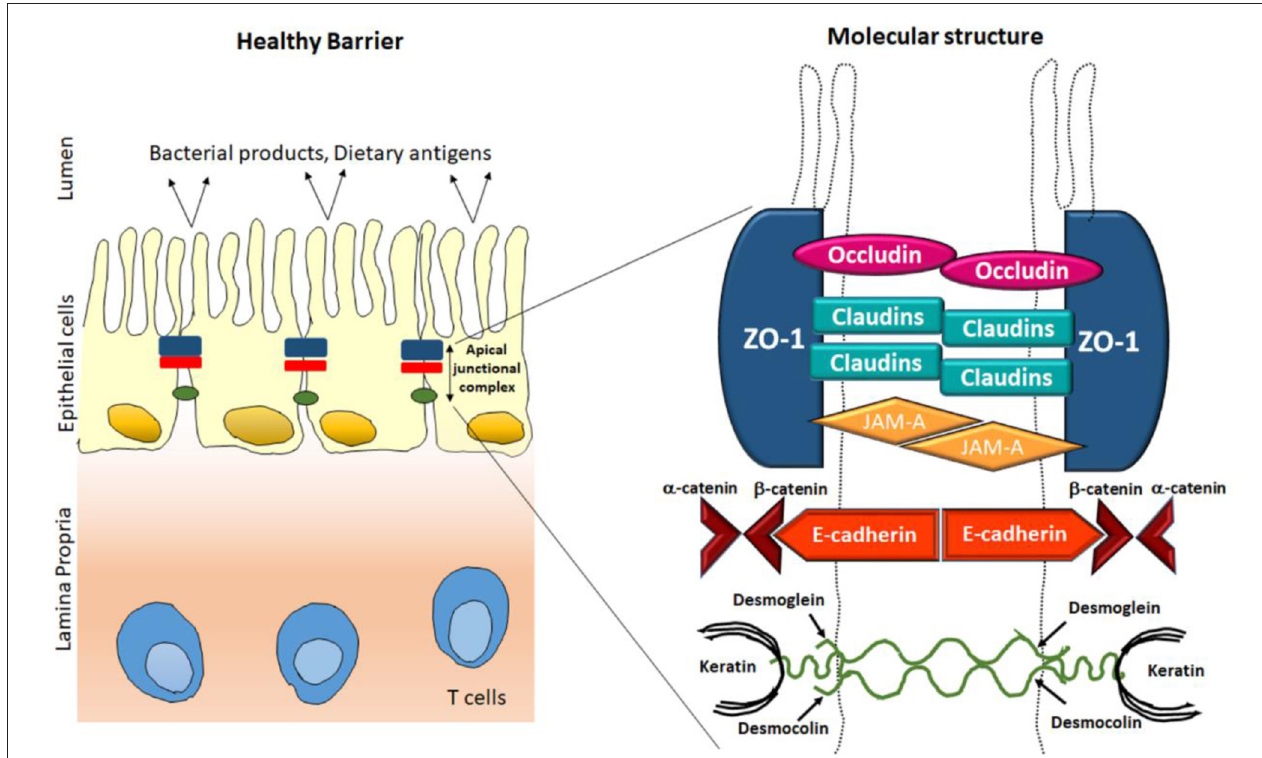
FIGURE 1 | Classical overview of epithelial tight junction’s structure in healthy